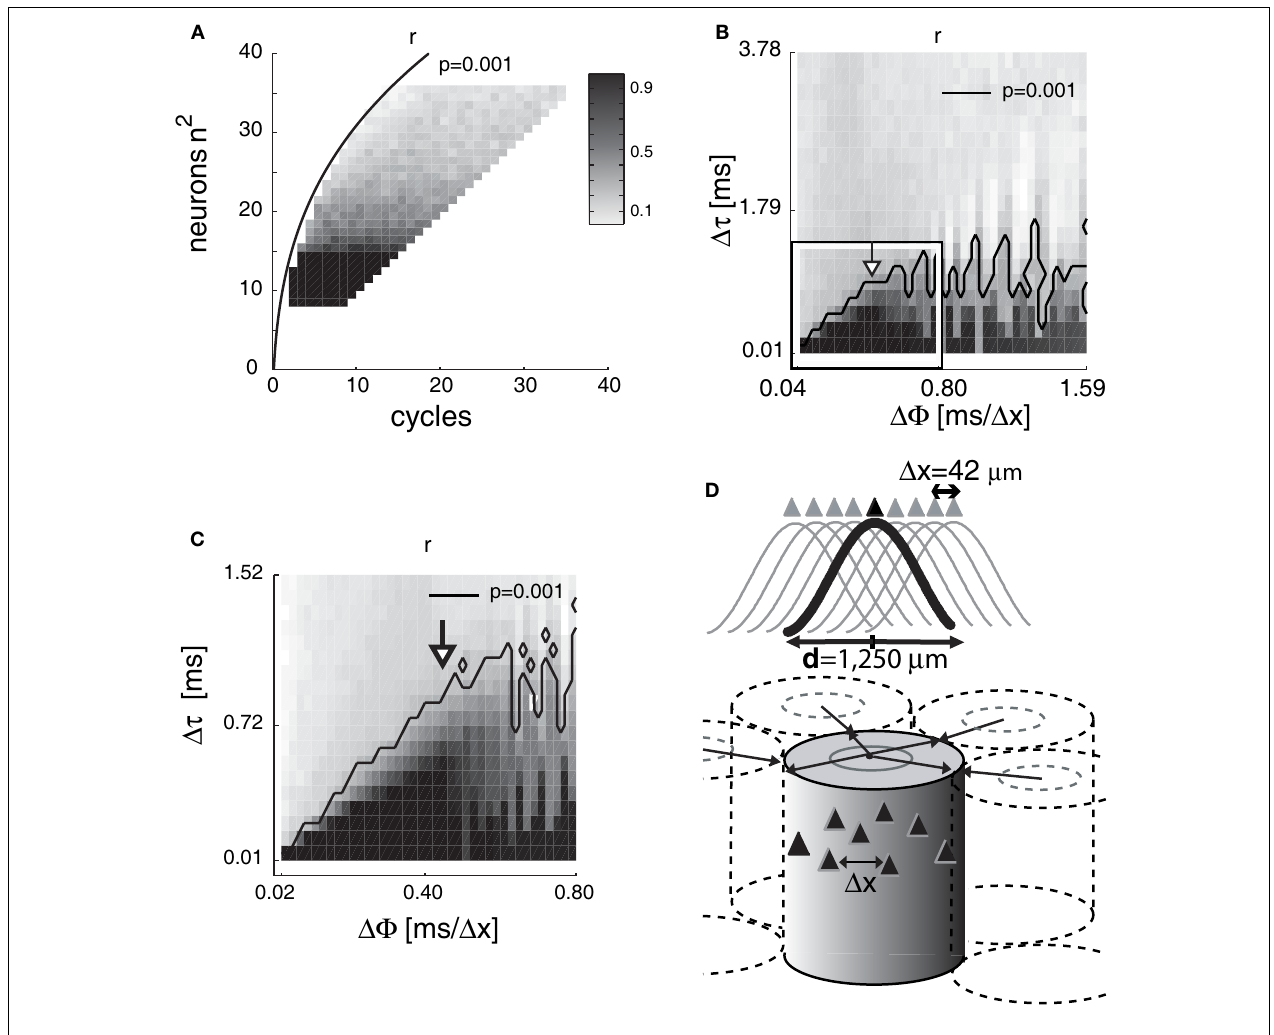
FIGURE 4 | The effi ciency of reconstruction depends on the number of neurons, gamma cycles, temporal resolution and phase gradient. (A) Average correlation coeffi cients ( r ) between original and reconstructed images (grayscale) as a function of number of gamma cycles (abscissa) and number of neurons (ordinate). The right side of the exponential curve represents combinations of number of neurons and gamma cycles that enabled precise reconstructions ( P < 0.001). (B-C) Average r as a function of temporal resolution (DT) and gamma phase gradient between adjacent neurons ( ΔΦ ). Unit is [ms/ Δ x ] where Δ x is the average nearest neighbor distance between pyramidal cells (D) . (C) A higher resolution simulation within parameter ranges